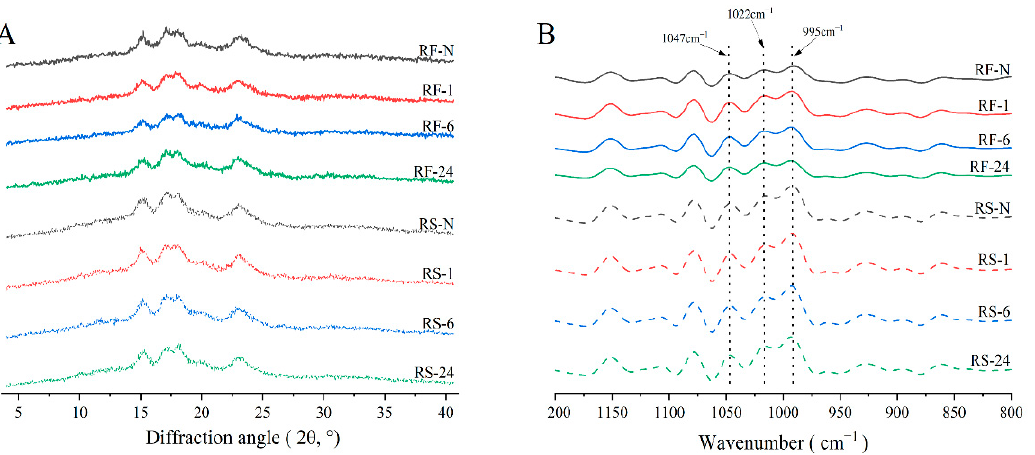
Figure 3. The X-ray diffraction ( A ) and deconvoluted FTIR ( B ) of native and partially hydrolyzed RF and RS. RF represents rice flour and RS represents rice starch; numbers refer to the hydrolysis time (h); RF-N is the rice flour and RS-N is native starch isolated from rice flour. Table 3. The XRD and FTIR parameters 1 of native and partially hydrolyzed RF and RS.